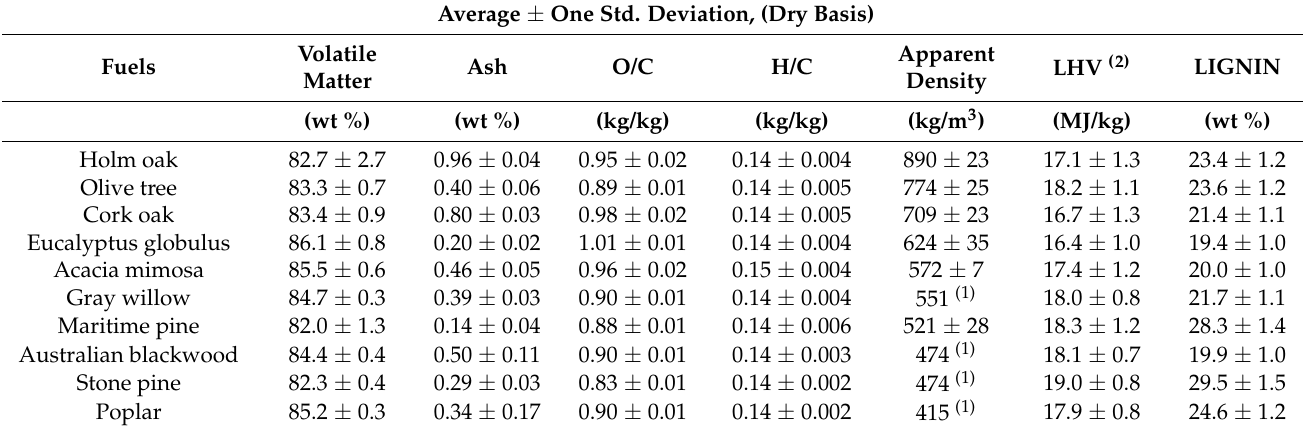
Table 1. Physicochemical properties of feedstocks. Average ± One Std. Deviation, (Dry